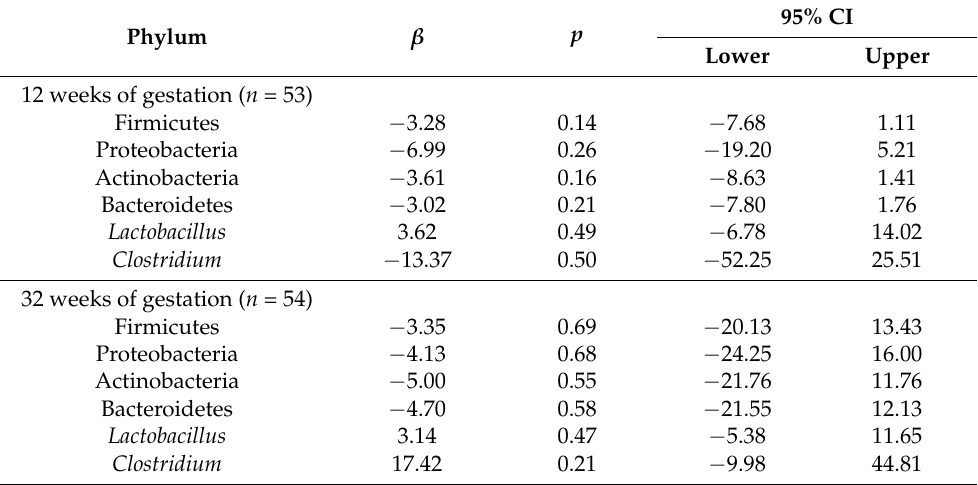
Table A1. Associations between the relative abundance of taxa in maternal feces and CB CCL17 levels 1 .